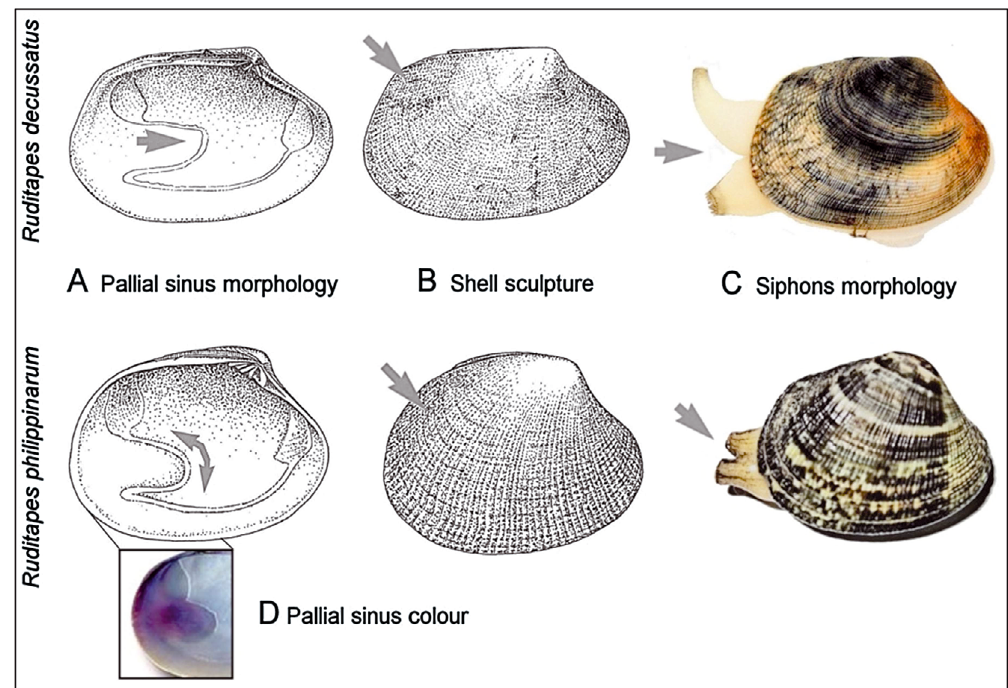
Fig. 2. Simplified identification scheme of Ruditapes decussatus and R. philippinarum showing the main morphological differences between the 2 species. A and B modified from Quéro & Vayne